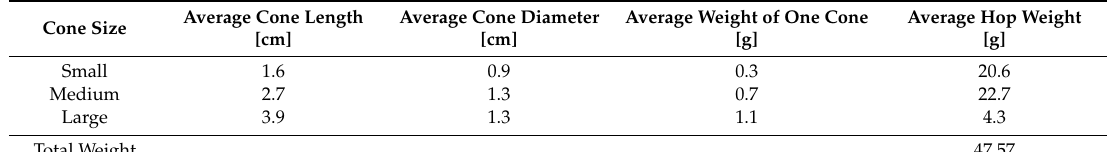
Table 3. Average hop cone size distribution within a hop